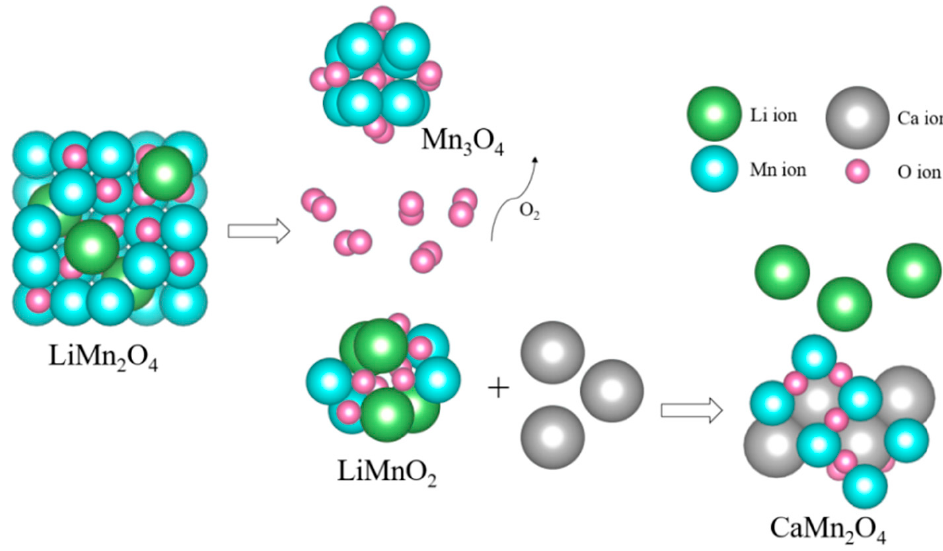
Figure 2. LiMn 2 O 4 and molten salt reaction process.